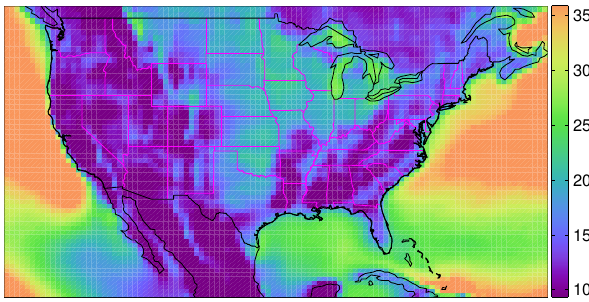
Fig. 7. Geographical variation of the mean wind power episode length (h) across the US.